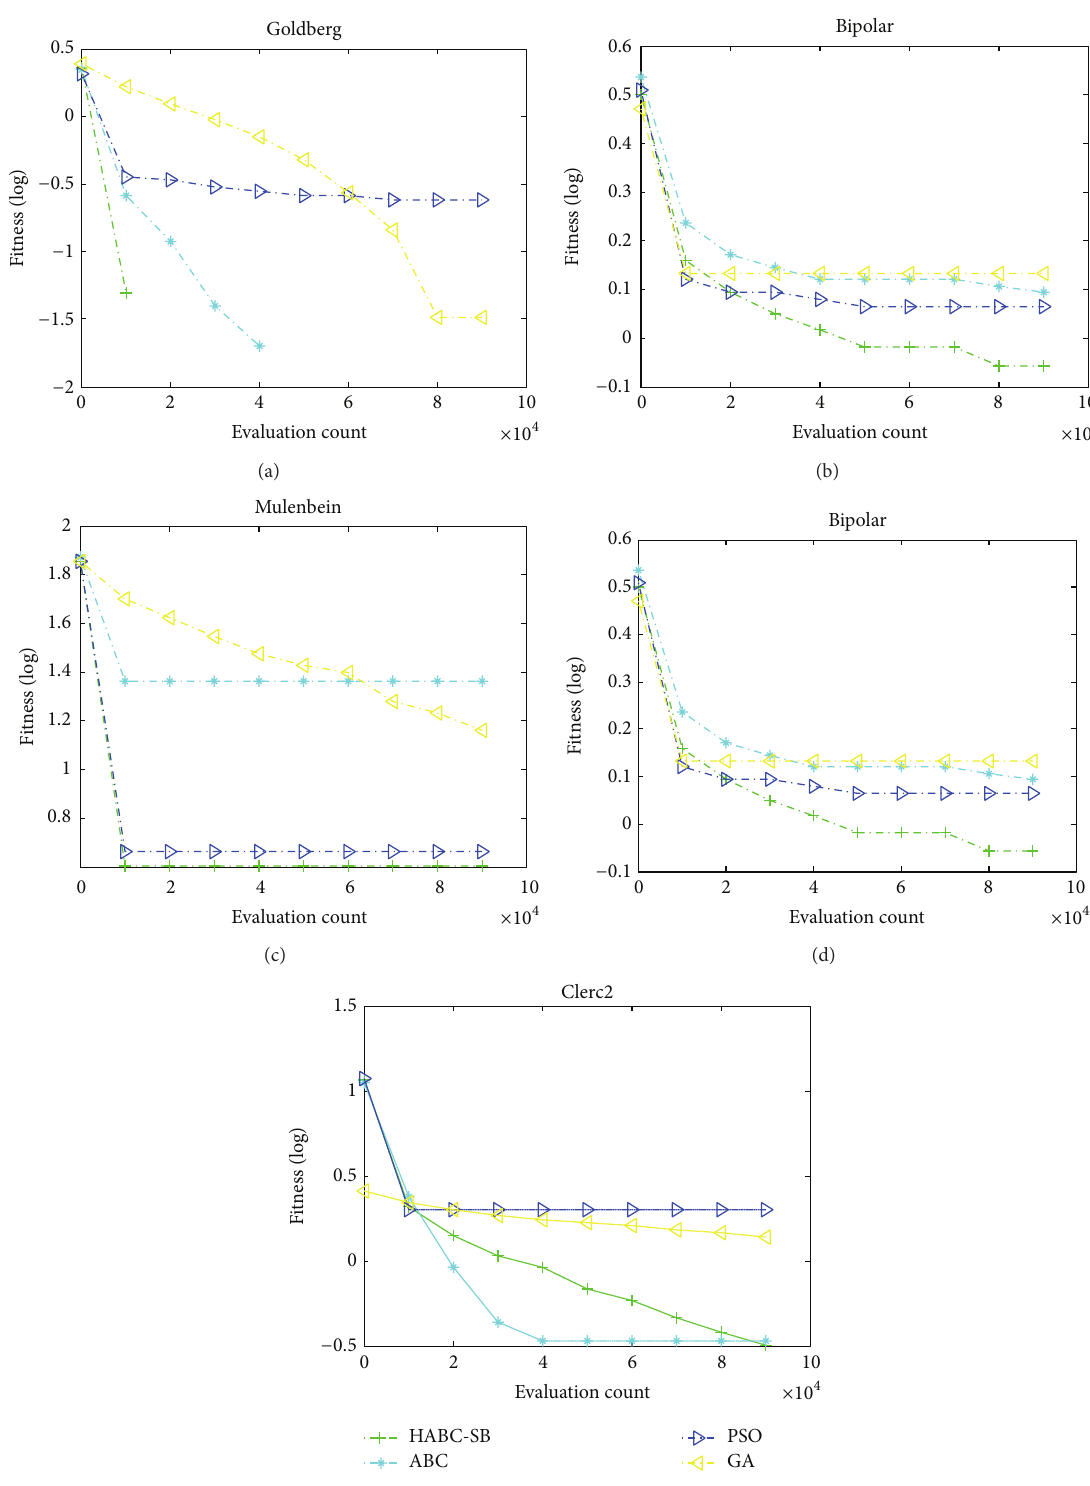
Figure 7: The median results of discrete functions. (a) Goldberg’s order-3. (b) Bipolar order-6. (c) Mulenbein’s order-5. (d) Clerc’s order-3 problem 1. (e) Clerc’s order-3 problem